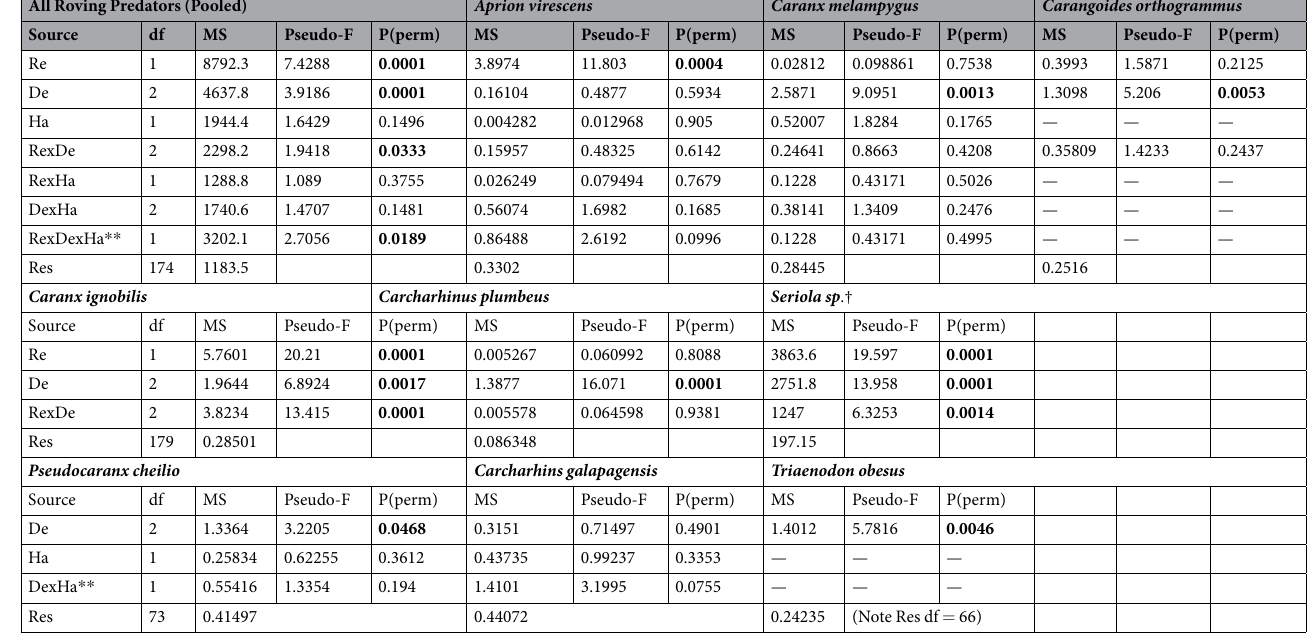
Table 3. PERMANOVA tests of pooled roving predator abundance (all species), Aprion virescens , Caranx melampygus , and Carangoides orthogrammus between region (Re), depth (De), and habitat strata (Ha). PERMANOVA tests of Caranx ignobilis , Carcharhinus plumbeus , and Seriola sp ** are presented for region x depth strata, following preliminary three-factor tests, and for Carcharhinus galapagensis and Triaenodon obesus between depth and habitat strata in the NWHI. Figures in bold indicate significant results. Total number of permutations per cell exceed 9700 except for the univariate factor test (depth) for Triaenodon obesus .